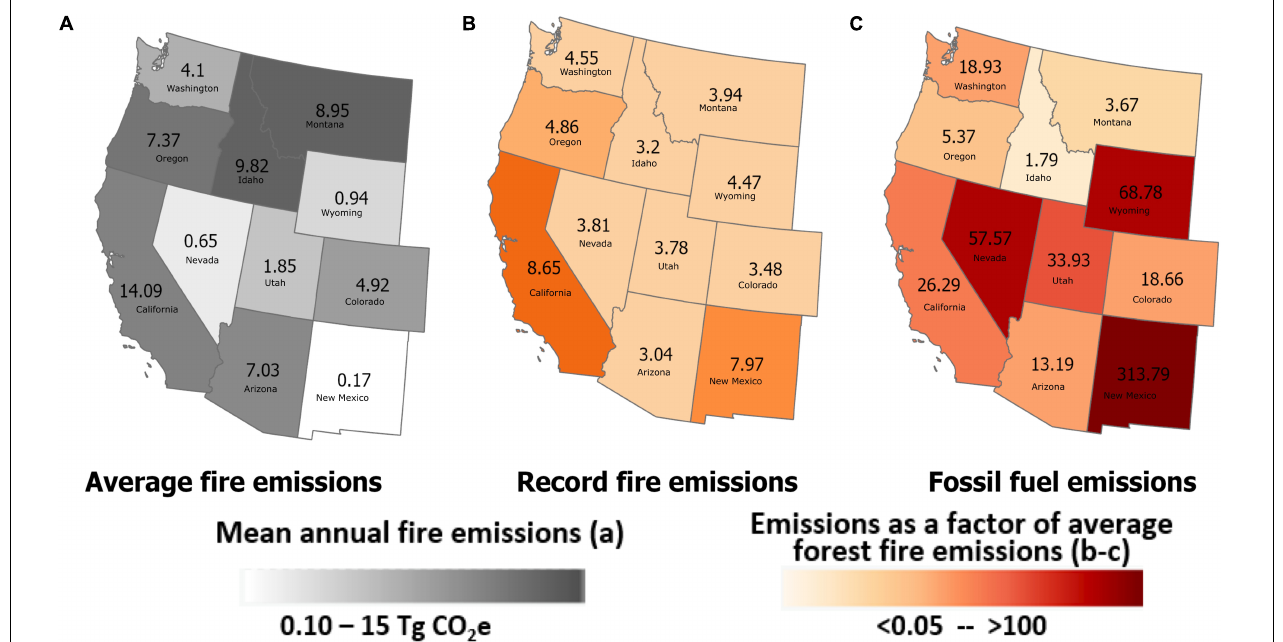
FIGURE 5 | Fossil fuel and record-year forest fire emissions as a factor of mean annual forest fire emissions for the baseline decade 2009–2018. This comparison shows (A) mean annual fire emissions (Tg CO 2 e) calculated per state for a baseline 10-year (2009–2018) period, and factors from mean annual forest fire emissions (i.e., the number of times higher, or the proportion of those emissions relative to mean annual forest fire emissions) for (B) record-year forest fire year emissions (i.e., the year with the highest forest fire emissions for that state, Table 4 ), and (C) mean annual fossil fuel emissions.